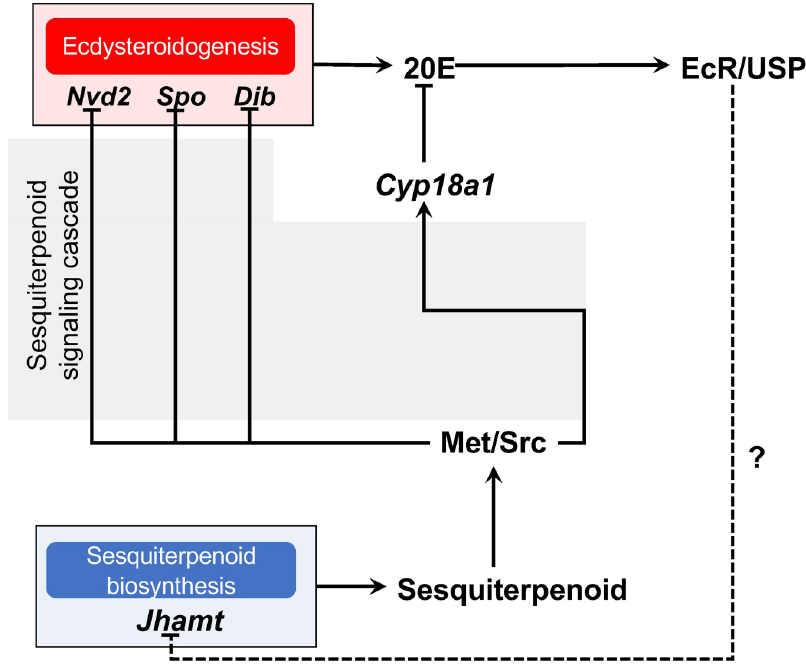
sesquiterpenoid signaling cascade downregulates ecdysteroidogenesis gene expression, hence suggesting antagonistic relationship between sesquiterpenoid and ecdysteroid.